Question: Draft a figure caption describing what is shown.
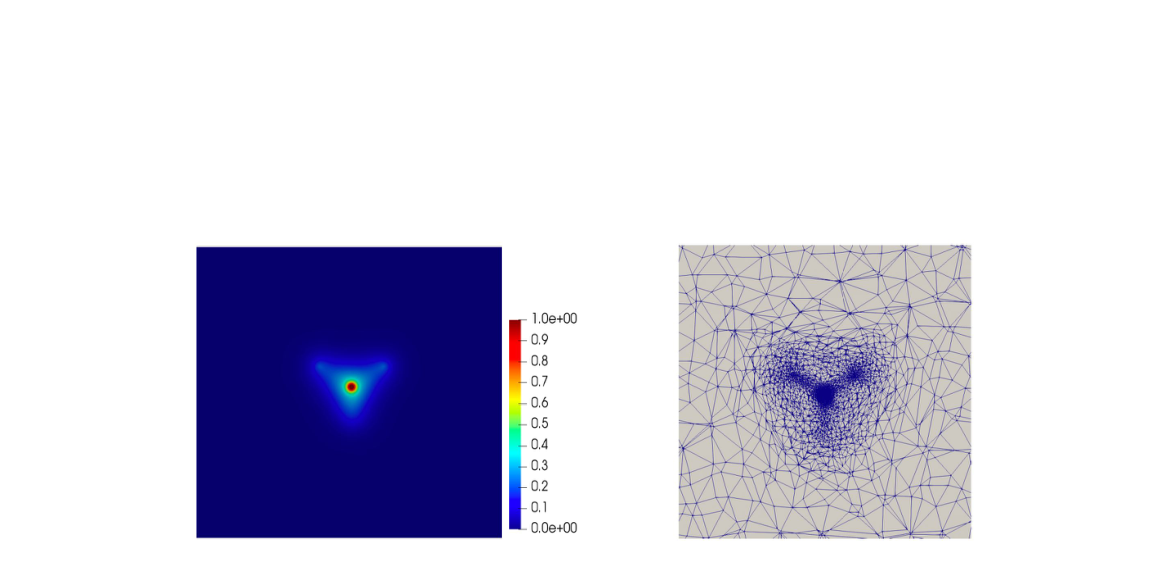
Answer: Contour plot of the electron density (left) and the adaptive moving mesh (right) for Example 3